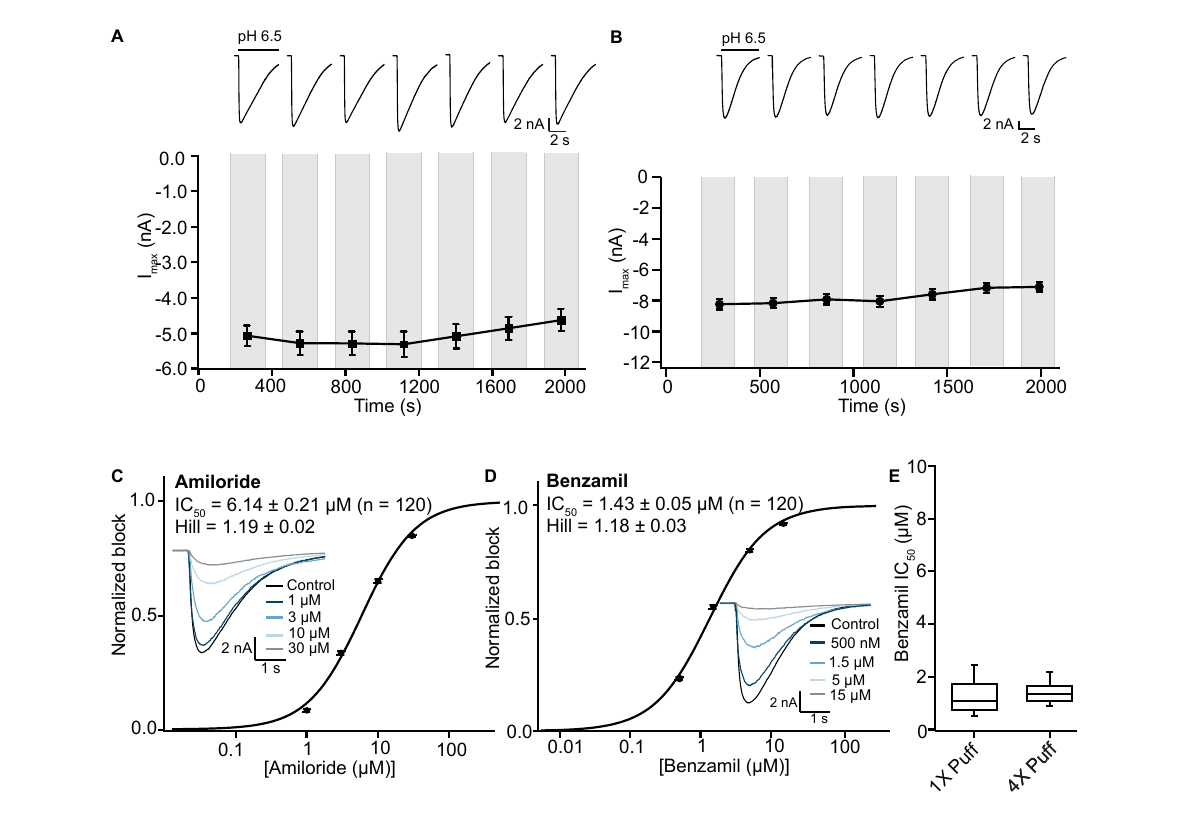
FIGURE8 Stable ASIC1a responses in single and multi-hole recordings on SP384i enable pharmacological screening. (A) Stable responses in a single hole well to repeated “puff” applications of pH 6.5 solution (top), and average current stability data from n = 50 wells (bottom; mean ± S.E.M). (B) Stable responses in a multi-hole well (4X) to repeated “puff” applications of pH 6.5 solution (top), and average current stability data from n = 60 wells (bottom; mean ± S.E.M). (C,D) Inhibition of ASIC1a responses on SP384i by Amiloride and Benzamil. Raw current traces (insets) in response to pH 6.5 “puff” activation after pre-incubation in indicated concentrations of drug enable construction of cumulative IC 50 curves for Amiloride (C) and Benzamil (D) , with indicated mean, S.E.M and n values and Hill slopes of 1.19 and 1.18, respectively. Multi-hole chips (4X) were used. (E) There is a wider spread of IC 50 values for Benzamil on 1X chips compared with 4X chips using the “puff” ligand application method, although the mean values were not statistically different ( P > 0.05, unpaired Student’s t test).